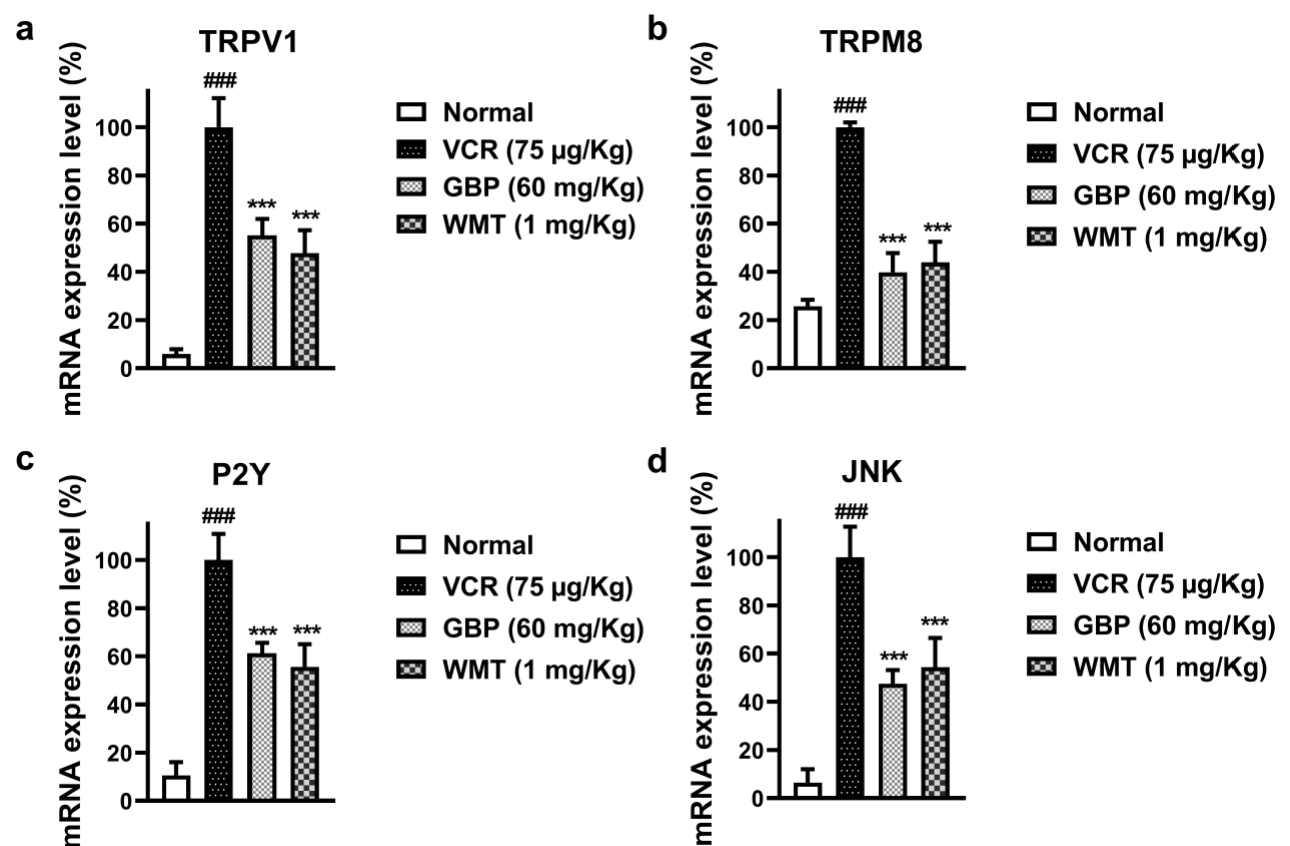
Figure 11. Effect of the WMT treatment on the TRPV1, TRPM8, P2Y, and JNK mRNA expression levels following VCR administration. TRPV1 ( a ), TRPM8 ( b ), P2Y ( c ), and JNK ( d ). The WMT treatment markedly reduced the mRNA expression level of the TRPV1, TRPM8, P2Y, and JNK proteins compared to the VCR group. All the results were expressed as the mean ( n = 5) ± SD. The experiment was performed in triplicate independently. ### p < 0.001 compared to the normal control group; *** p < 0.001 compared to the VCR group. Table 2. The sequences of the forward and reverse primers.